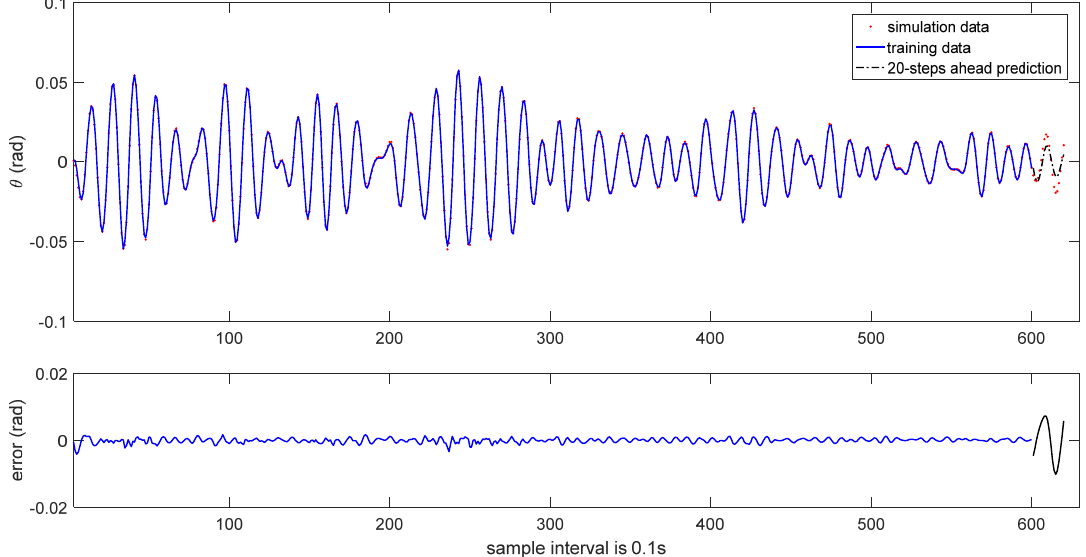
Figure 7. The 20-steps-ahead prediction of pitch motion in irregular waves for the R-Class Icebreaker model. When the sliding data window receives new sample data, the above modeling pro- cess will be repeated. For example, as the sliding data window moves to the sampling instant k = 687, the corresponding identified model is given as follows: